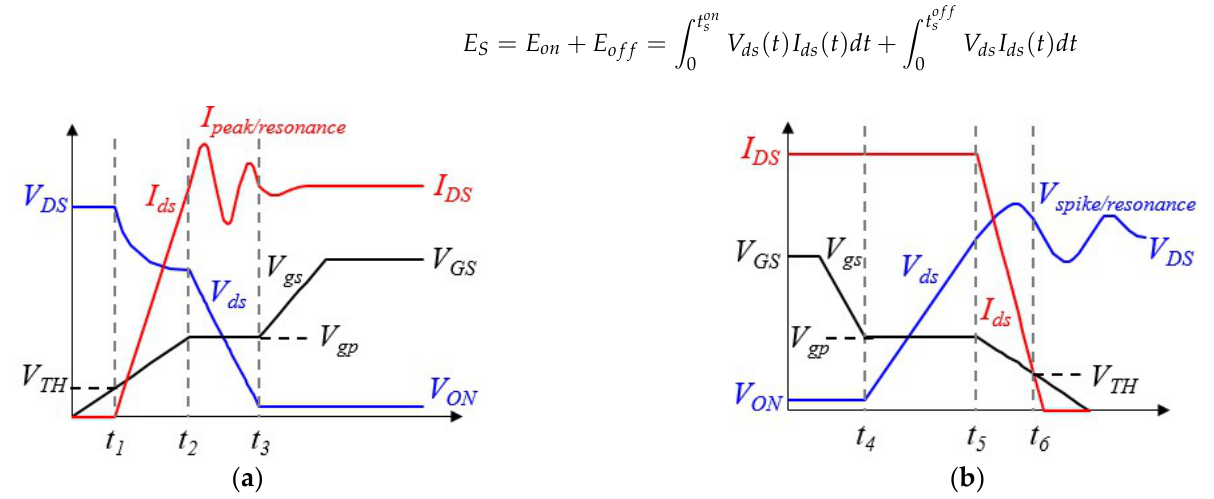
Figure 4. Power MOSFET switching transient: ( a ) turn-on waveform and ( b ) turn-off waveform.